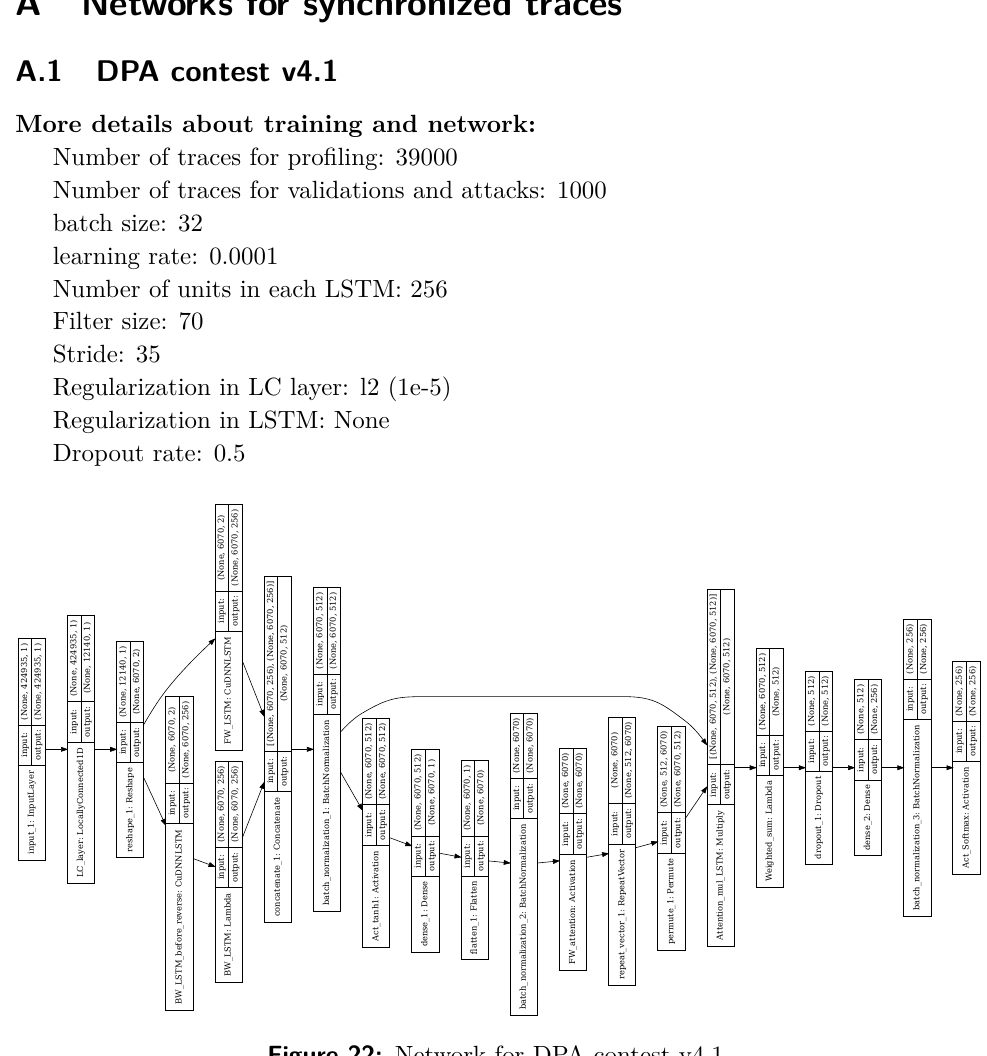
Figure 22: Network for DPA contest